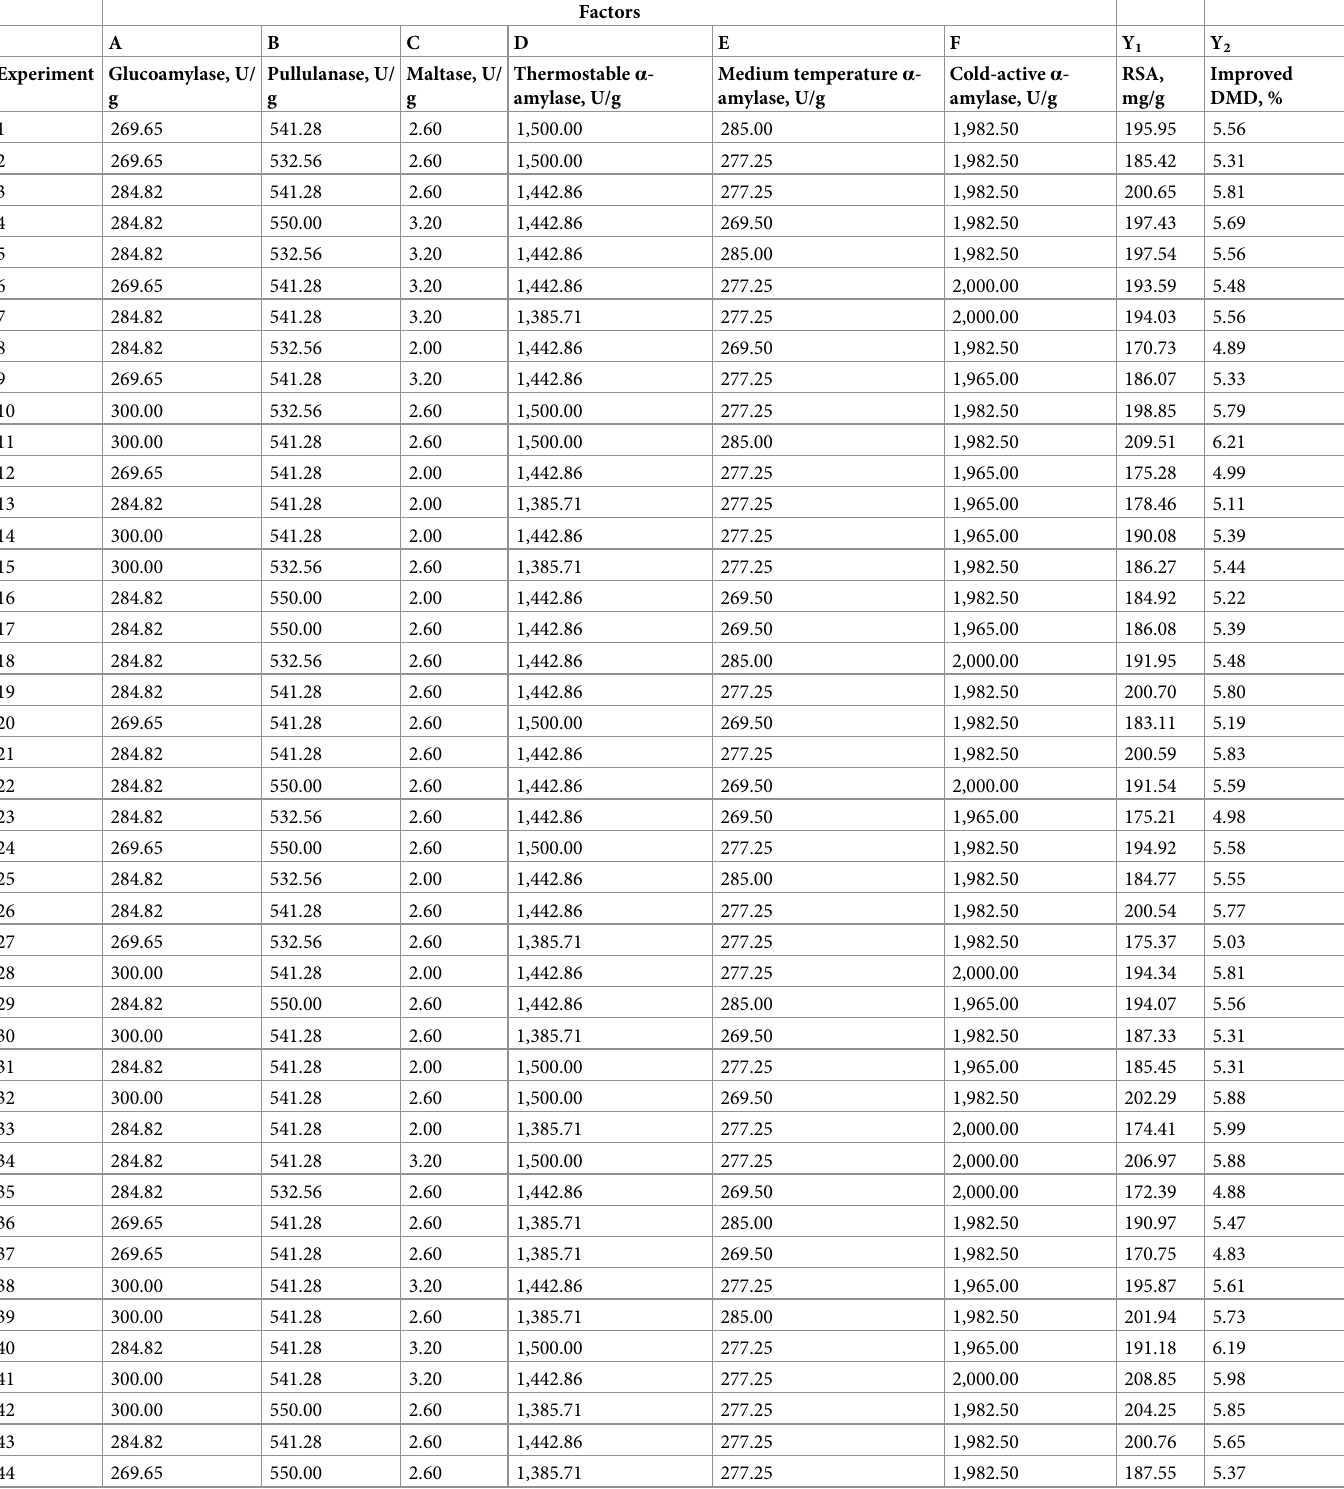
Table 5. Box-Behnken design of exogenous carbohydrases with coded values, predicted RSA and improved DMD.